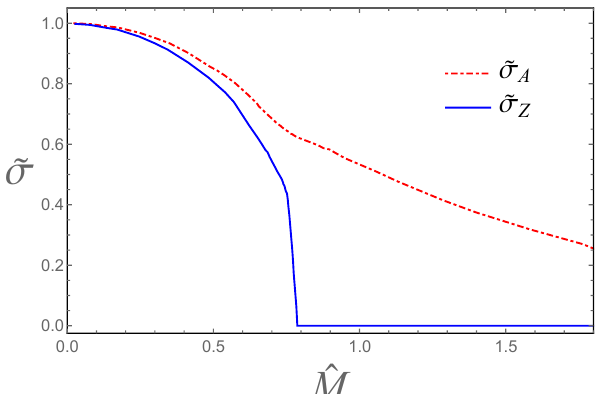
Figure 11. The anomalous transport as a function of ˆ M ≡ ˆ M 1 = ˆ M 2 , i.e. along the diagonal line in the phase diagram from left bottom to right top, at zero temperature with c/b = 2 . q 1 = q 2 = 1 , λ 1 = λ 2 = 1 / 10